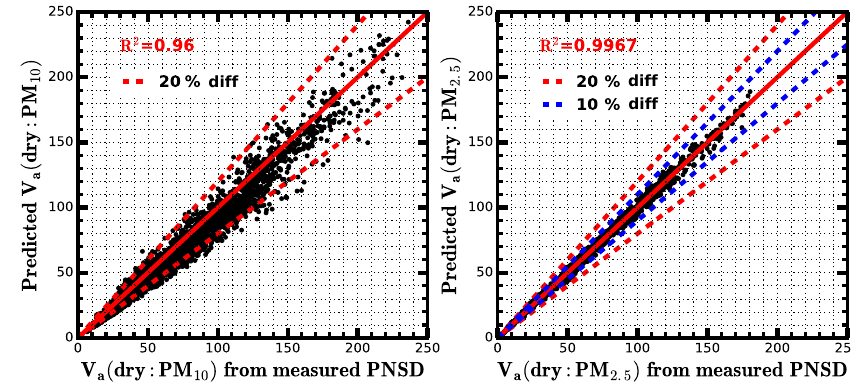
Figure 9. The comparison between V a (dry) (µm 3 cm − 3 ) of PM 10 or PM 2 . 5 , calculated from measured PNSD and V a (dry) of PM 10 or PM 2 . 5 , which are predicted based on six optical parameters measured by the “dry” nephelometer, by using the random forest model. R 2 is the square of correlation coefficient. The solid red line is the 1:1 line, dashed red lines and dashed blue lines represent 20 and 10% relative difference lines.